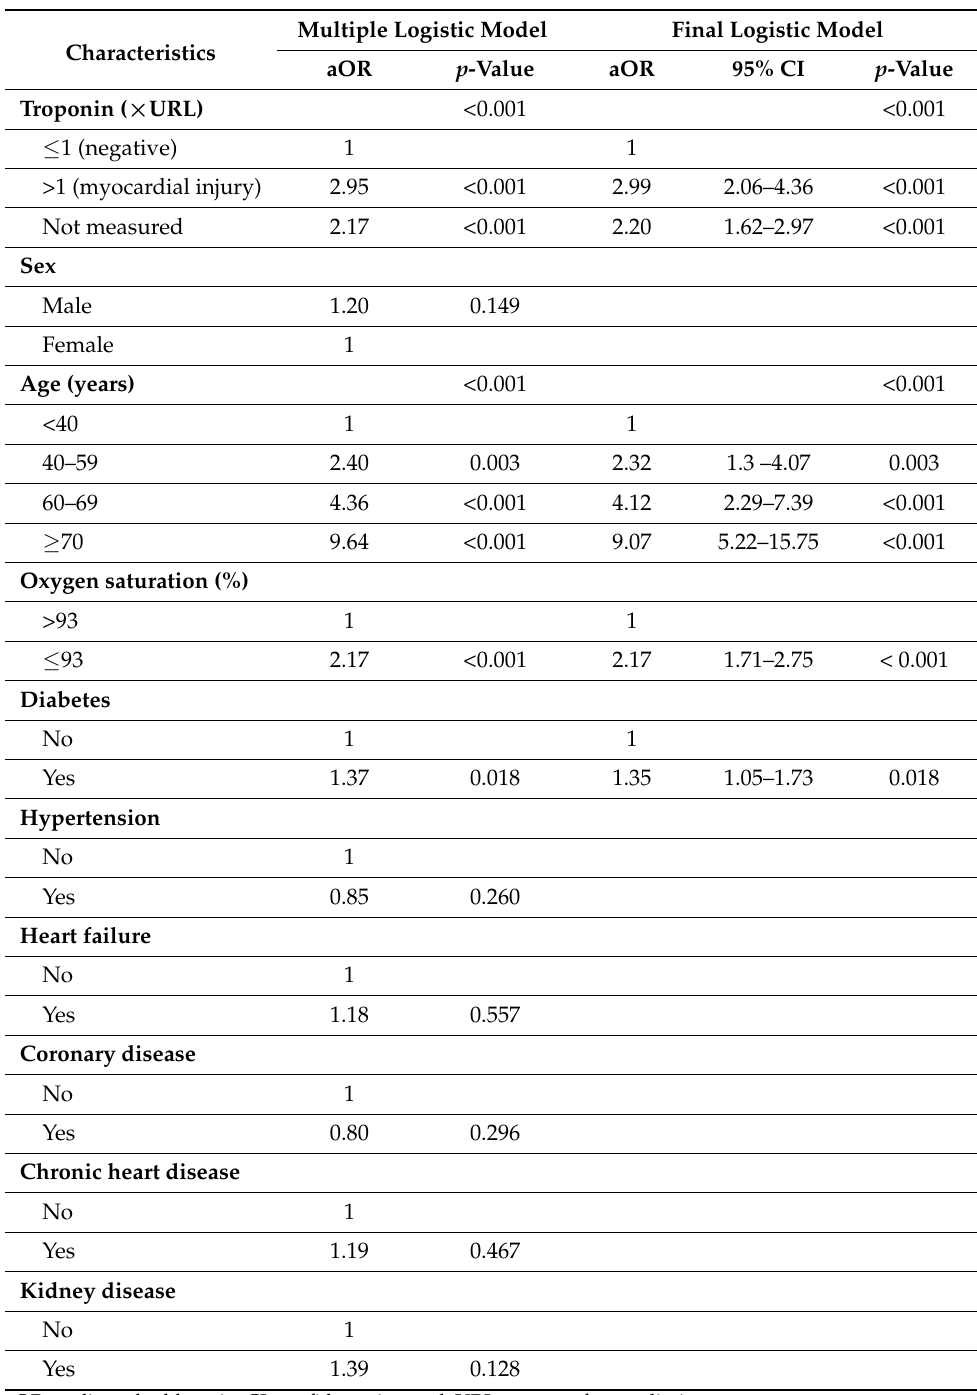
Table 4. Multivariate analysis findings for the prediction of in-hospital mortality among patients with